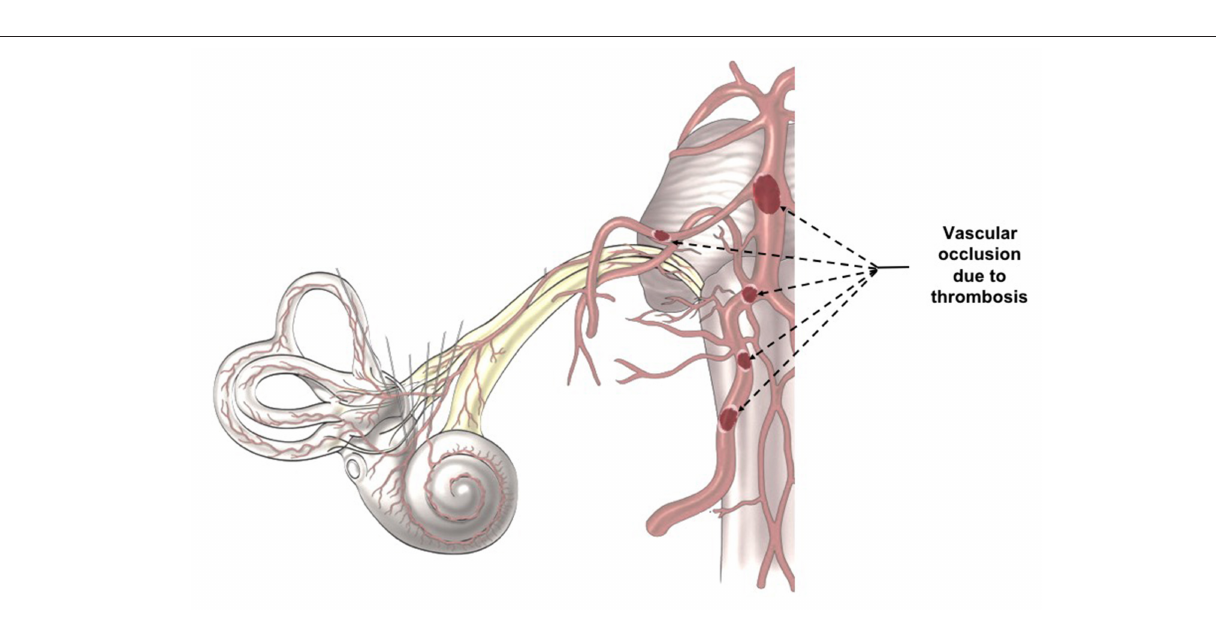
FIGURE 3 | Indirect Virus Effect. The images illustrates the different position of a potential trombosis, which can determine the onset of the audio-vestibular disorders because it stops the blood flow in the audiovestibular